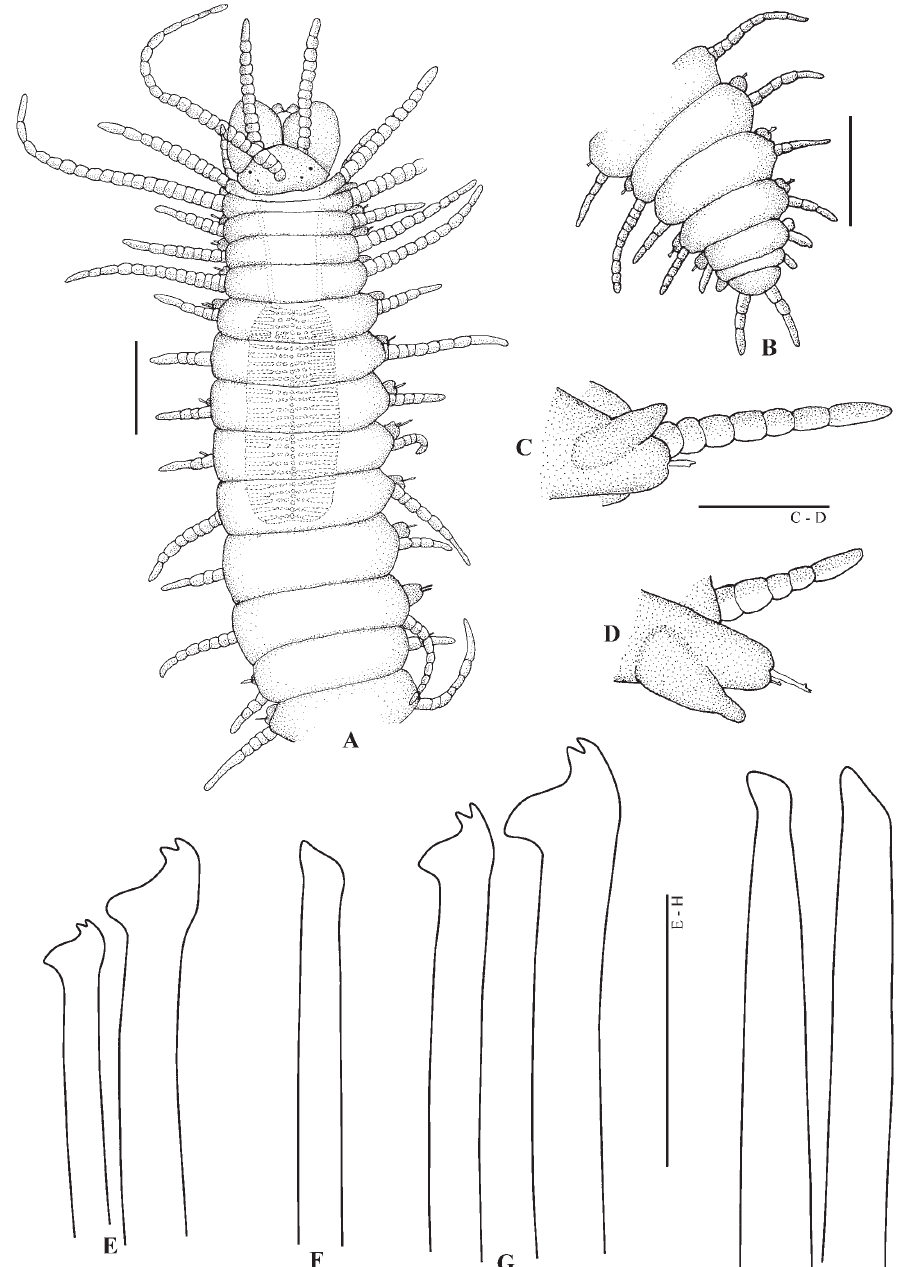
Fig . 1. – Hand-drawing of Haplosyllis aplysinicola n. sp. A, anterior end, dorsal view. B, posterior end, dorsal view. C, anterior parapodium, chaetiger 5. D, posterior parapodium. E, anterior chaetae, chaetiger 4. F, anterior acicula, chaetiger 4. G, mid-body chaetae. H, mid-body aciculae. Scale bars: A-B (200 m m), C-D (100 m m), E-H (20 m m). Holotype INV-ANE